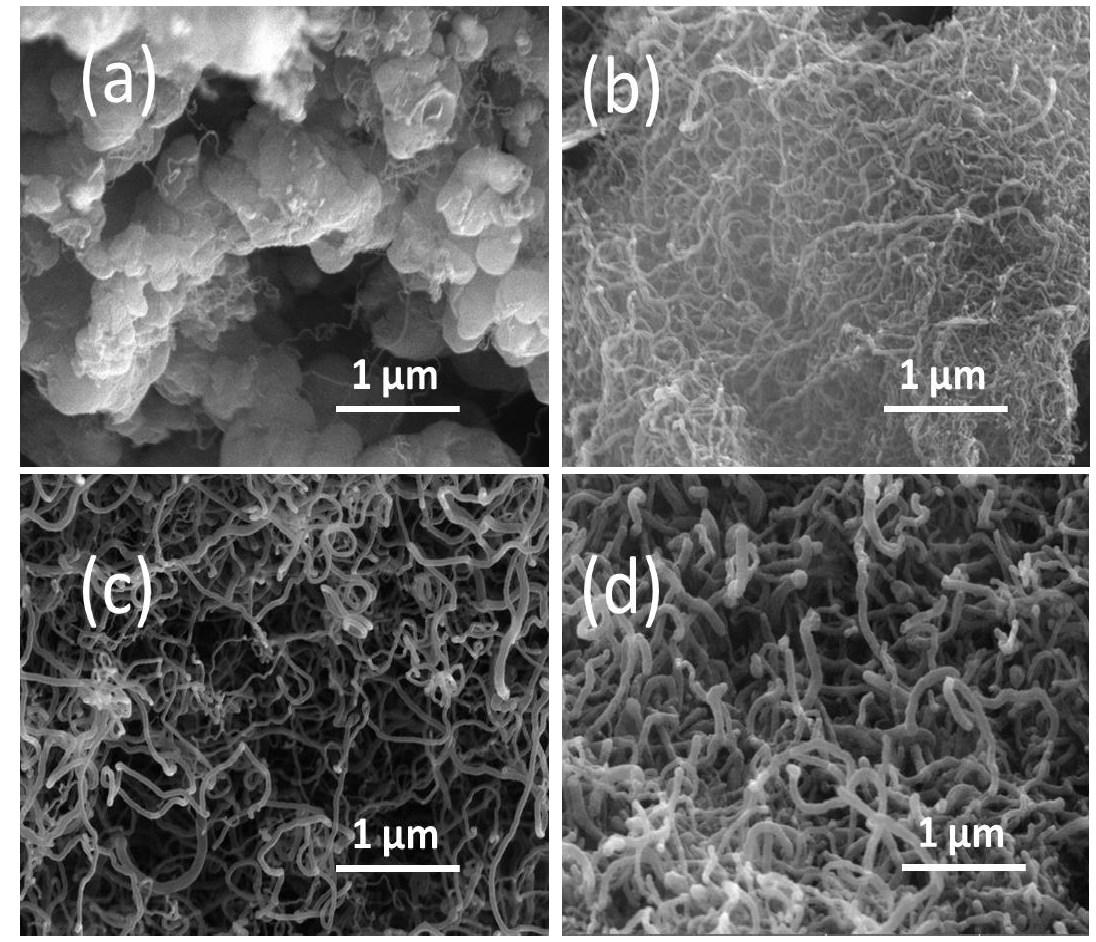
Figure 11. FE-SEM images of spent catalysts after DRP over 50 h (a) SrNiO 3 /NiF(R), (b) SrNiO 3 /NiF(F), (c) SrNiO 3 / γ- Al 2 O 3 (R), and (d) SrNiO 3 / γ- Al 2 O 3 (F).